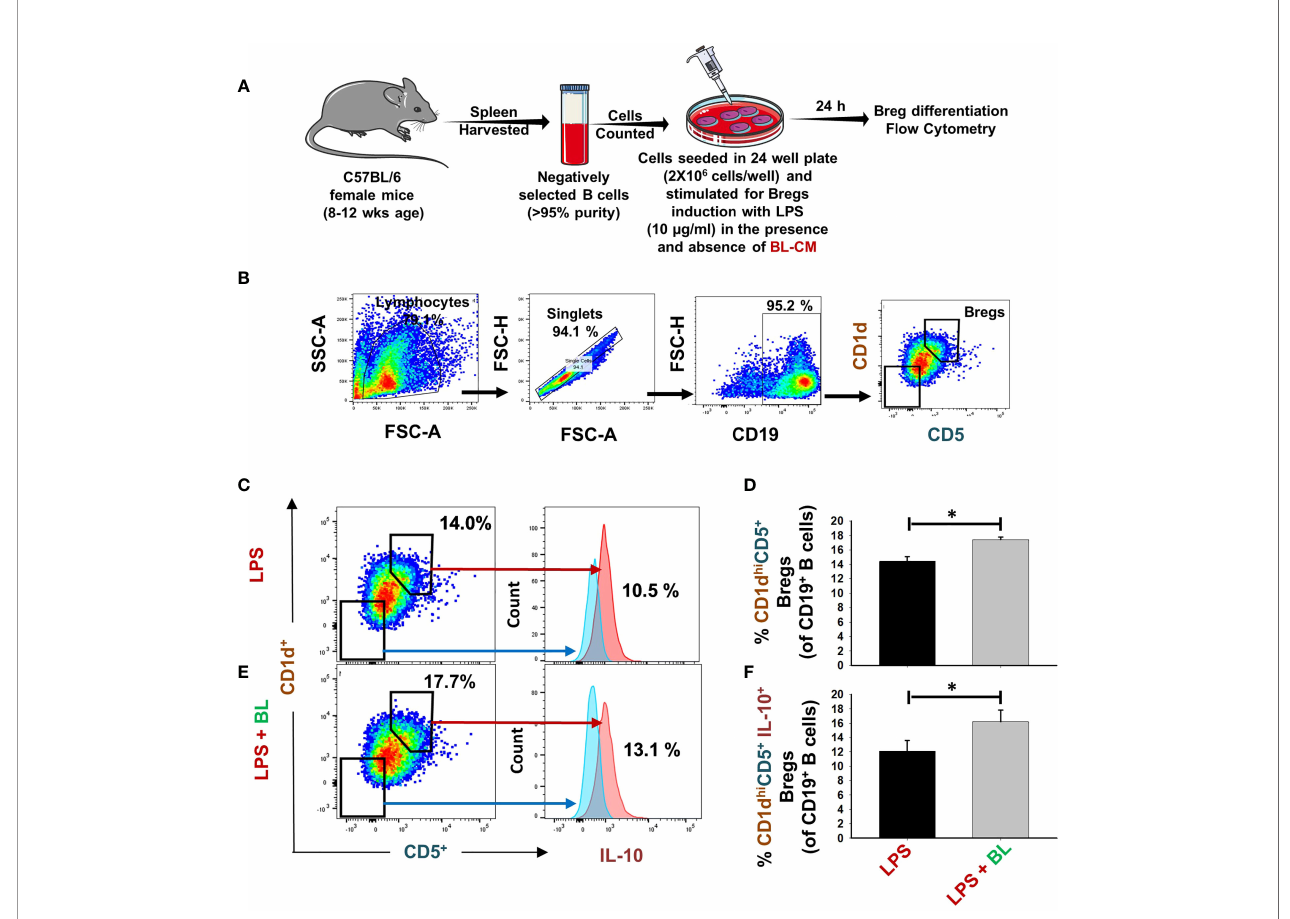
FIGURE 2 | BL enhances differentiation of IL-10-producing Bregs: (A) For Bregs stimulation, splenic CD19 + B cells were positively/negatively selected and stimulated with LPS (10 µg/ml) in the presence and absence of BL-CM at 1:5 dilution. After 24 h, cells were analyzed for CD1d CD5 and IL-10 expression by FACS. (B) Gating strategy followed for data analysis. (C) Dot plots and histograms depicting the percentages of CD19 + CD1d high CD5 + Bregs and CD19 + CD1d high CD5 + IL-10 + Bregs in control. (D) Bar graphs depicting the percentages of CD19 + CD1d high CD5 + Bregs. (E) Dot plots and histograms depicting the percentages of CD19 + CD1d high CD5 + Bregs and CD19 + CD1d high CD5 + IL-10 + Bregs in BL. (F) Bar graphs depicting the percentages of CD19 + CD1d high CD5 + IL-10 + Bregs. The above images are indicative of one independent experiment, and similar results were obtained in at least three independent experiments (n ≥ 3). Statistical signi fi cance was considered as p ≤ 0.05 (*p ≤ 0.05) with respect to indicated